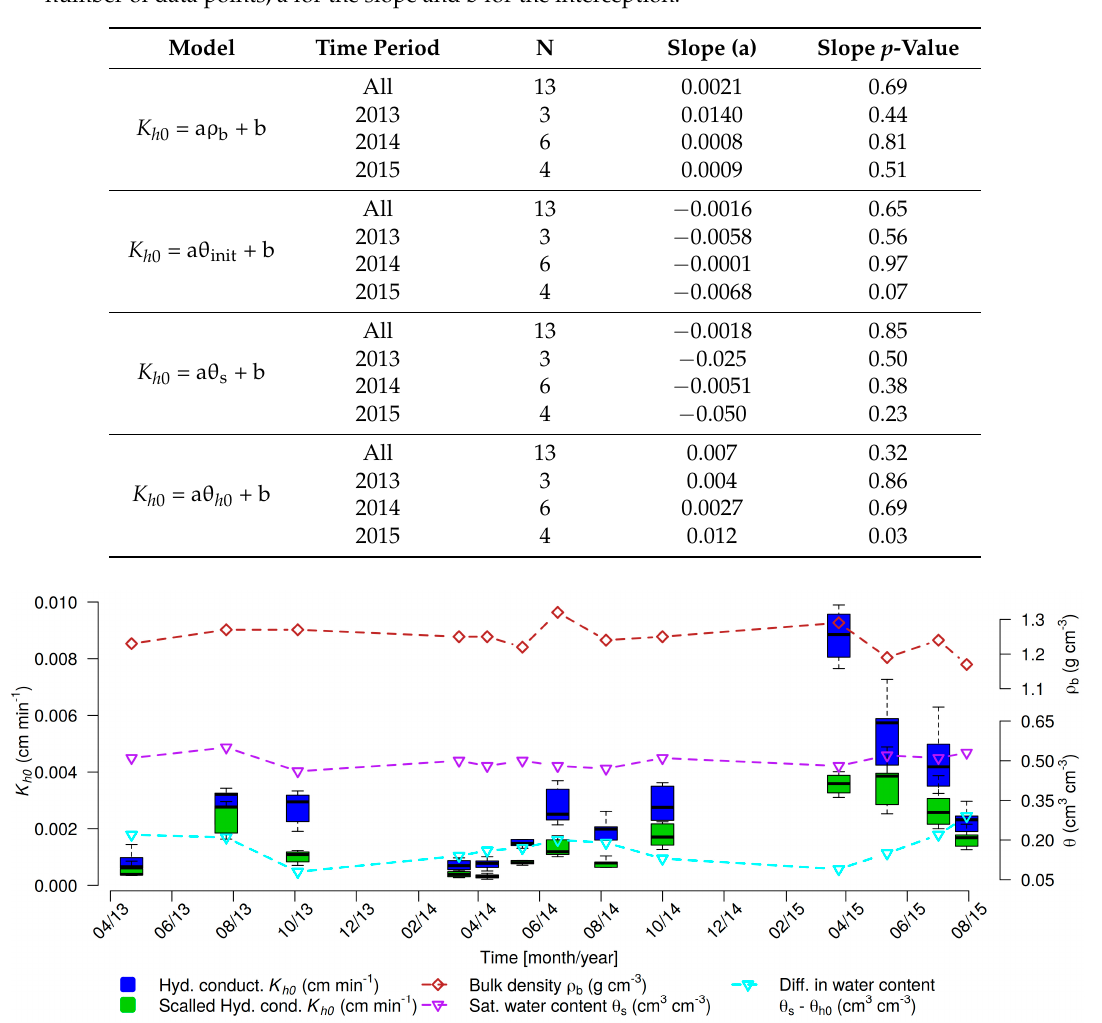
Figure 7. Seasonal variation of unsaturated hydraulic conductivity at the pressure head of − 3 cm (blue boxes before retention curve scaling, green boxes after scaling). The bottom and top of the box are the first and third quartiles and the band inside the box represents the weighted average of K h 0 weighted by inverse values of the RMSE. Ends of whiskers represent minimal and maximal values of K h 0 . Dashed lines stand for bulk density, saturated water content and fraction of empty pores at the pressure head of − 3 cm.